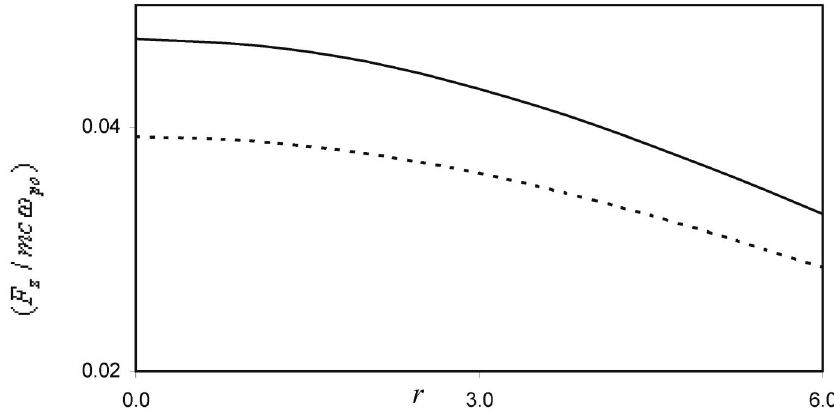
(cid:4) generated by a matched laser pulse, as a function of (cid:29)=L in plasma channel (solid curve) =mc! z po (cid:2) 0 : 1 , $ (cid:2) 15 : 0 & m , r (cid:2) 15 : 0 & m , and r (cid:2) 4 : 0 & m p o o